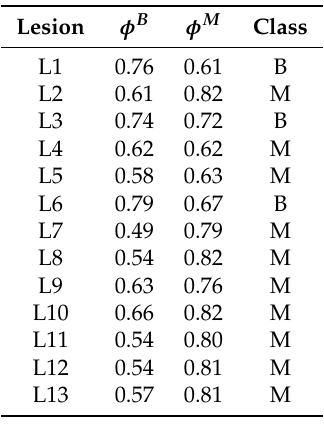
Table 1. A sample of global confidence degrees for benign and malignant classes of 13 lesions obtained when applying Choquet integral on dual energy contrast enhancement mammography (DECEDM) texture features. Correct recognition rate here is 85%.